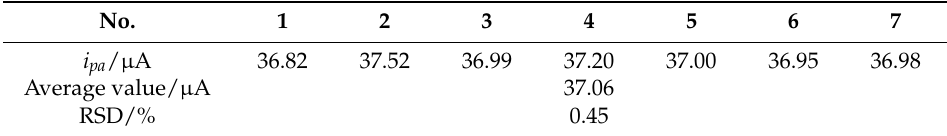
Table 2. The reproducibility of TiO 2 –ErGO–GCE determination of tartrazine.